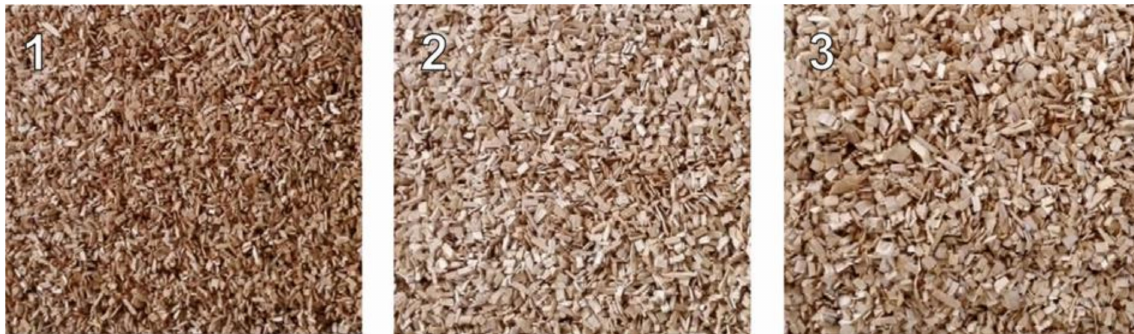
Figure 4. Individual fractions of pure oak wood chips after screen analysis. ( 1 )—less than 3.15 mm, ( 2 )—3.15 to 5 mm, ( 3 )—greater than 5